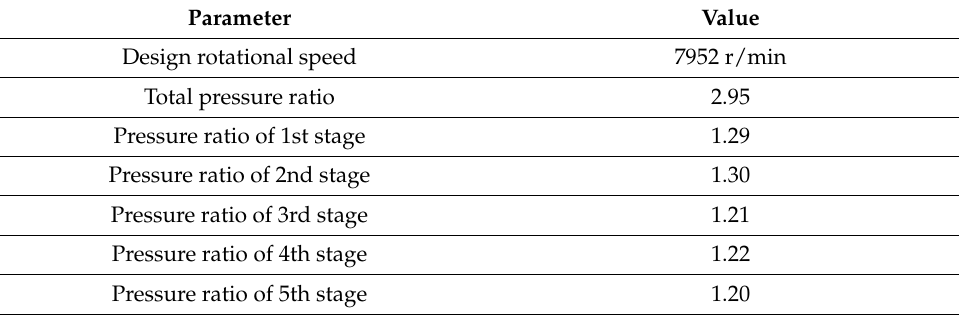
Figure 1. Structural diagram of multistage compressor. Table 1. Some design parameters of multistage